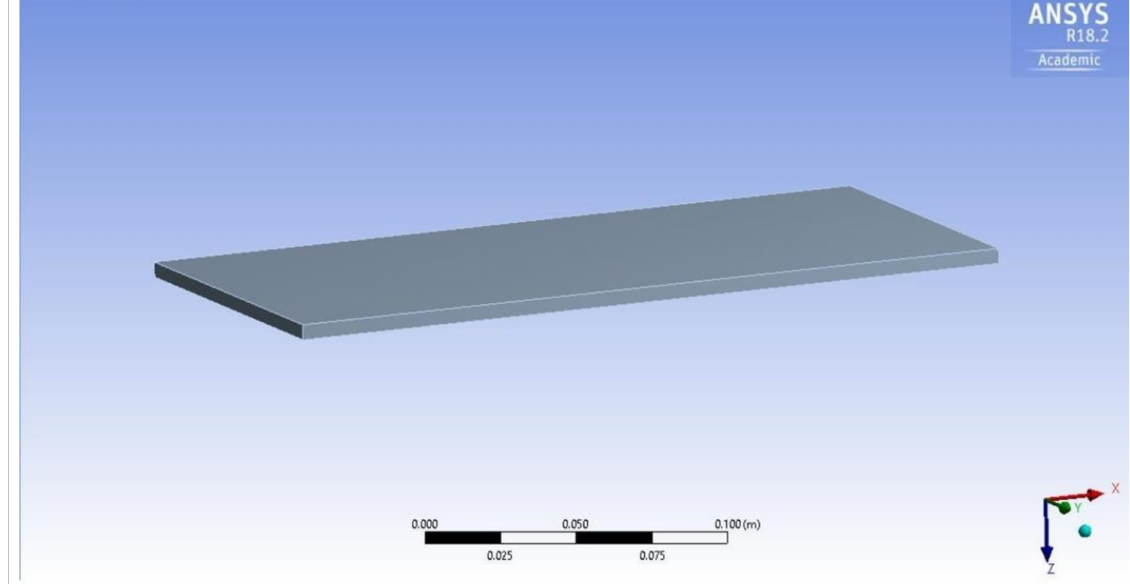
Figure 1. The studied plate with dimensions of 250 mm in length, 125 mm in width and 5 mm in thickness, using